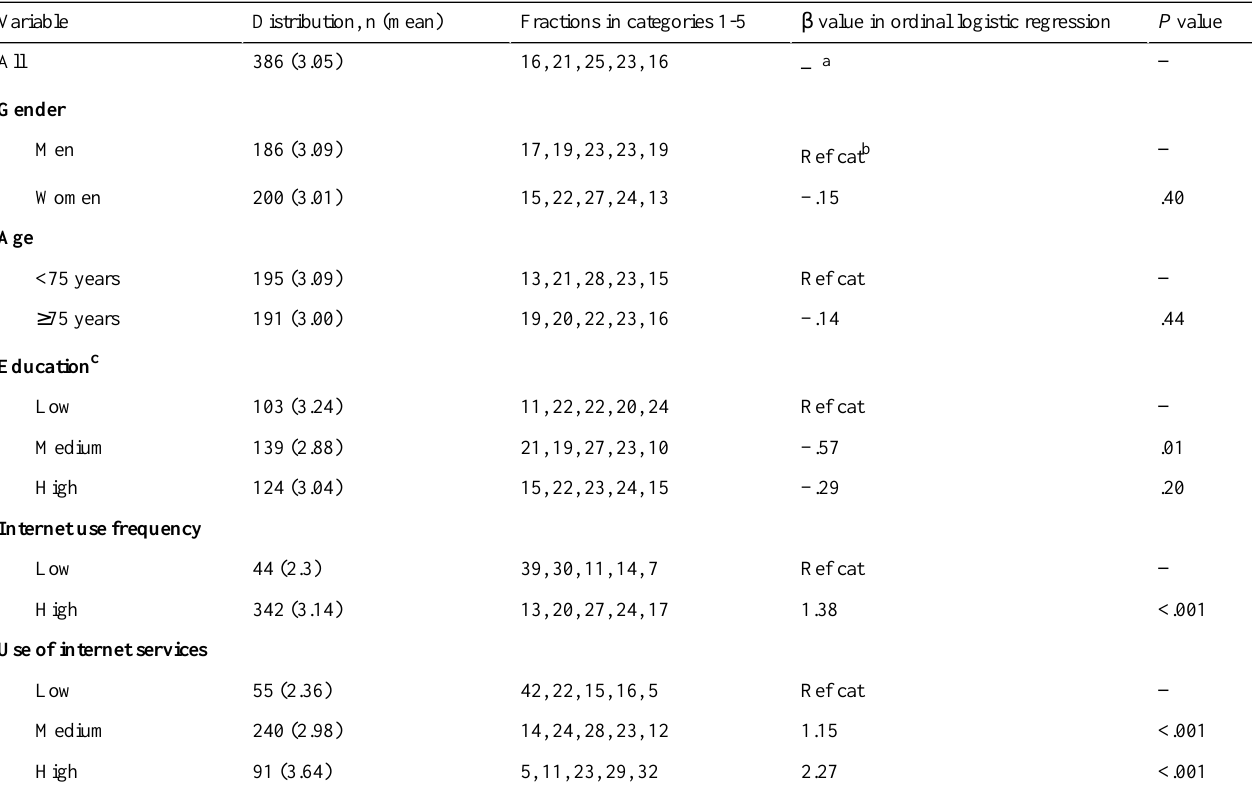
Table 4. Distribution of social score among the study participants and associations between social score and independent variables presented as β coefficients from univariate ordinal logistic regression